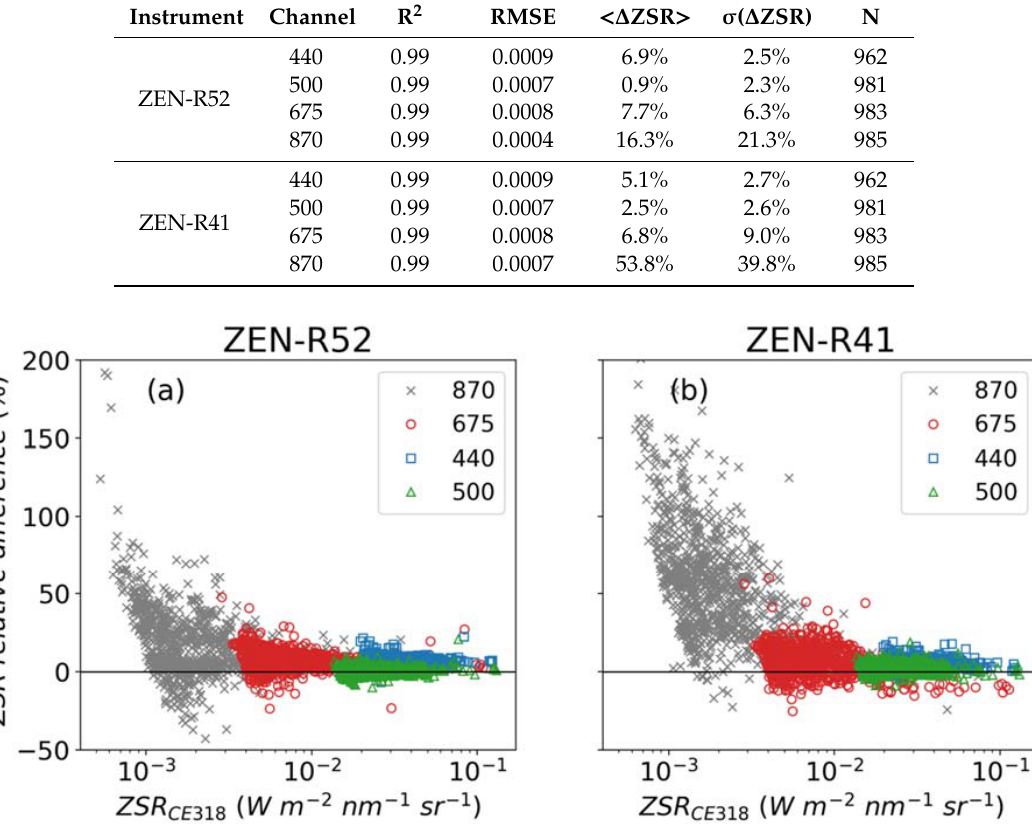
Figure 6. ZSR relative di ff erences between ( a ) ZEN-R52 and ( b ) ZEN-R41 against CE318-AERONET ((ZSR ZEN-R -ZSR CE318 ) / ZSR CE318 ) in logarithmic scale at the four coincident channels: 870 nm (grey crosses), 675 nm (red circles), 440 nm (blue squares), and 500 nm (green triangles).